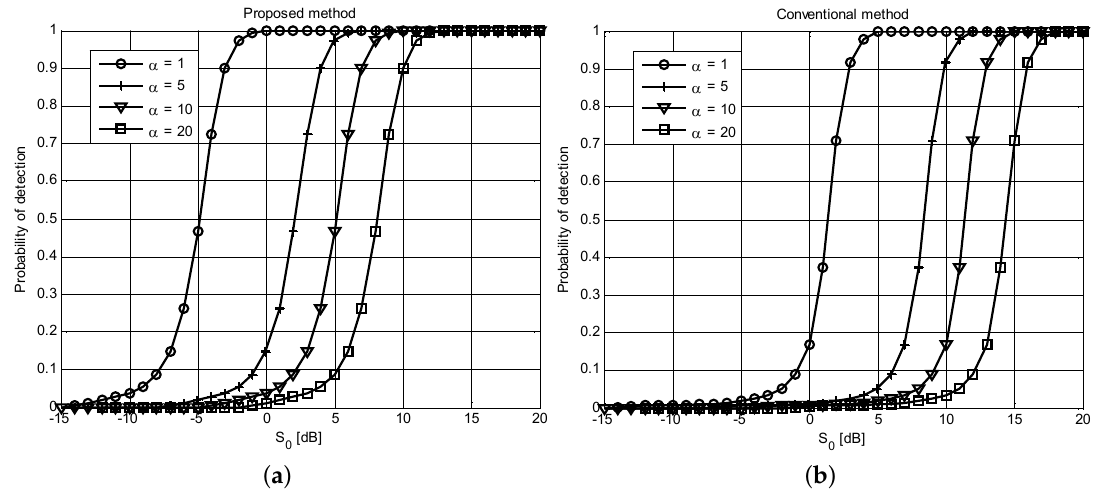
Figure 3. Numerically obtained probabilities of detection for α = 1, 5, 10, and 20 when λ = 1 and P FA = 0.005. ( a ) Time-reversal-based detection; ( b ) Conventional